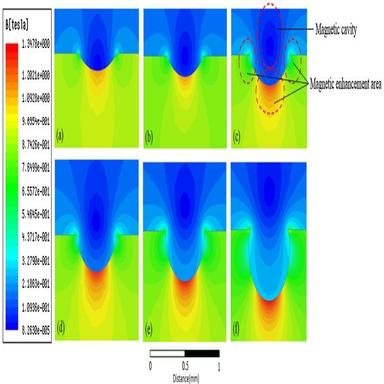
Simulation results of different arc-shaped defect circle center depths for HMM; (a) Arc-shaped defect circle center depth of 0.25 mm; (b) Arc-shaped defect circle center depth of 0.2 mm; (c) Arc-shaped defect circle center depth of 0.15 mm; (d) Arc-shaped defect circle center depth of 0.1 mm; (e) Arc-shaped defect circle center depth of 0 mm; (f) Arc-shaped defect circle center depth of 0.1 mm.